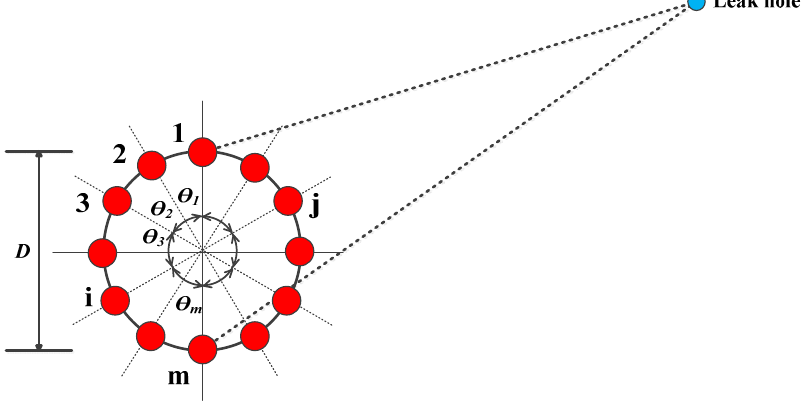
Figure 1. Circular sensor array arrangement with reference to the leak hole.